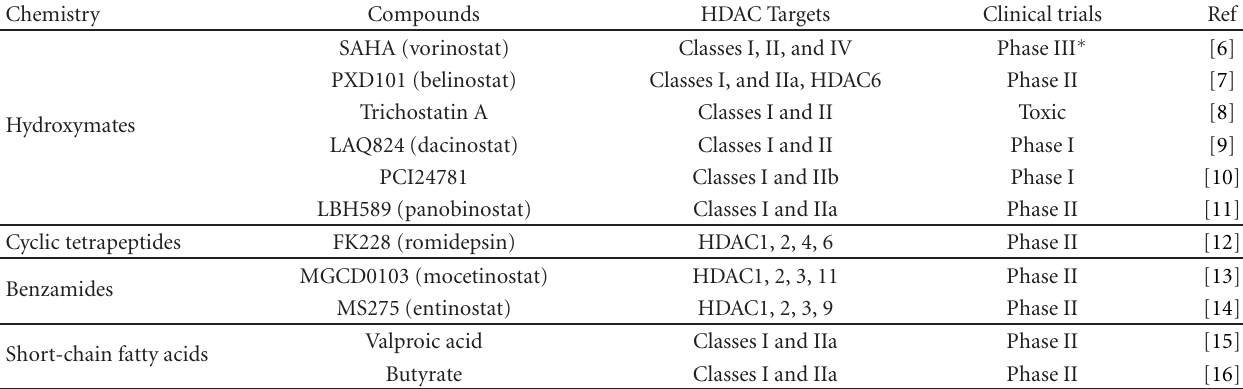
Table 1: Characteristics of HDAC inhibitors in clinical